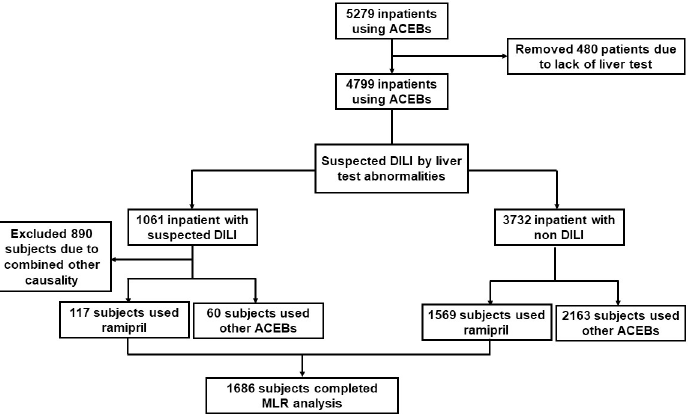
Fig 1. Data processing. ACEIs: angiotensin converting enzyme inhibitors; DILI: Drug-induced liver injury; MLR: multiple logistic regression.